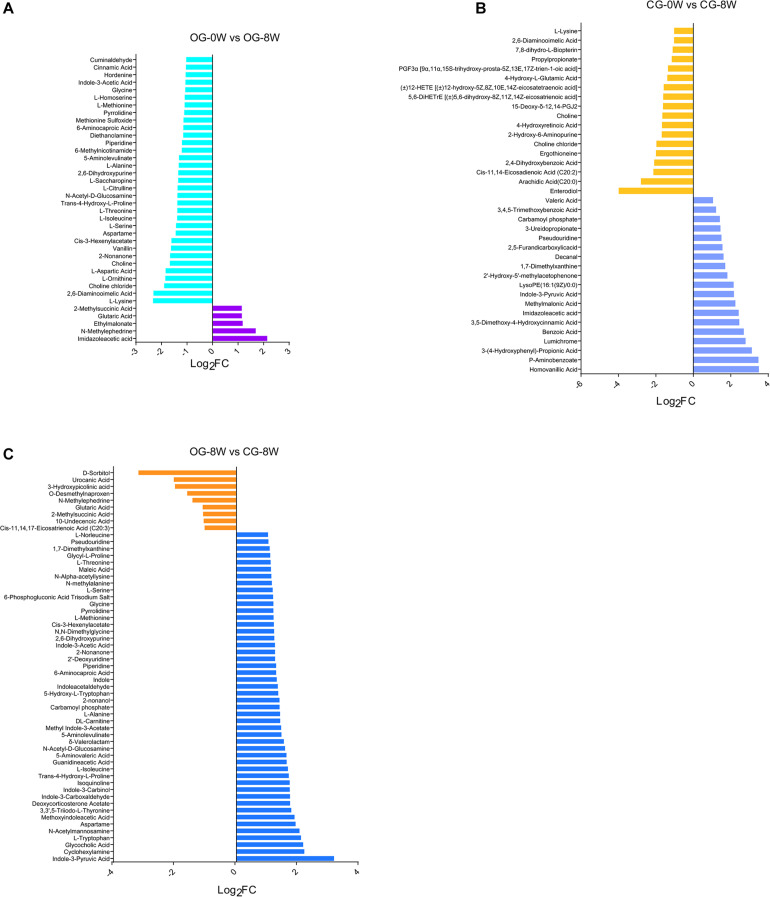
Bar-chart of the distinct metabolites between week-groups based on Log2FC value: (A) OG-0W and OG-8W; (B) CG-0W and CG-8W; (C) OG-8W and CG-8W.